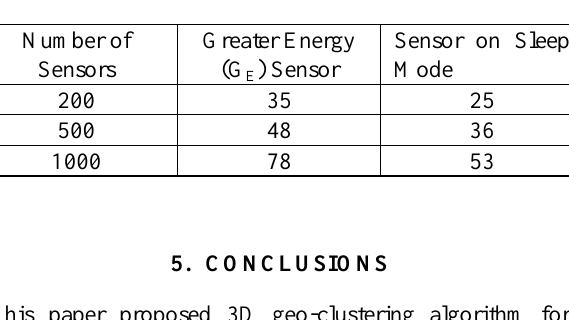
sensors in overlap area. E